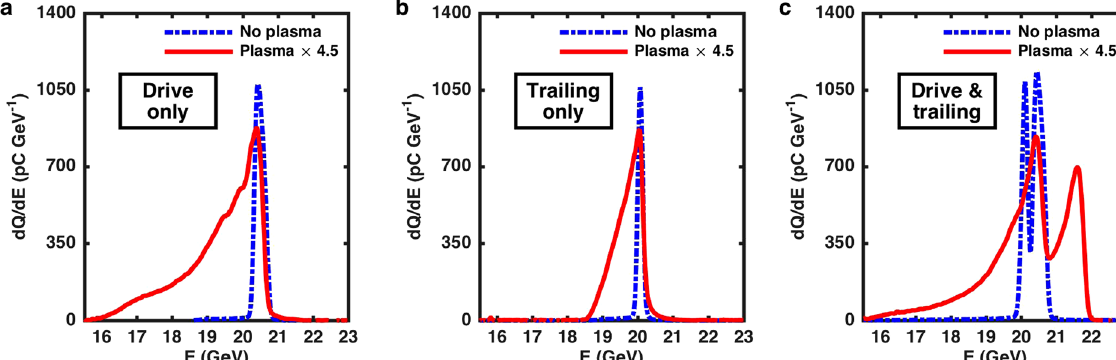
Figure 2. Evidence of acceleration of a positron bunch. Positron energy spectra measured by the Cherenkov energy spectrometer with (red solid line) and without plasma (ionizing laser off, blue dash-dotted line). In ( a) only the drive bunch is sent, in ( b) only the trailing bunch is sent, and in ( c ) both the drive and the trailing bunches are sent through the lithium oven, in which case the trailing bunch is accelerated from 20.05 GeV to above 21 GeV by the plasma wake. The plasma data is multiplied by 4.5 in ( a – c) . The spectrum c with plasma is one of the 160 spectra from the dataset used in Fig. 3.